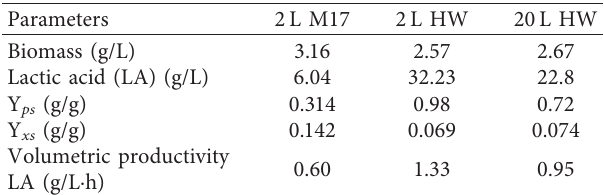
Table 1: Main experimental data from the different batch cultures of Enterococcus faecalis